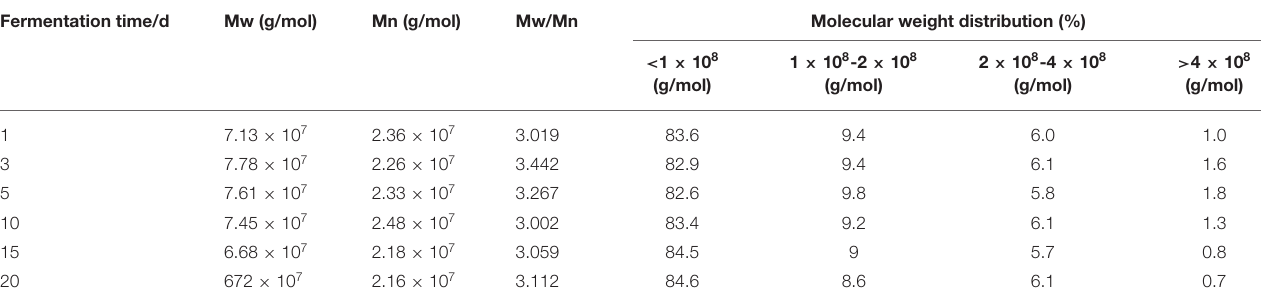
TABLE 5 | Effect of natural fermentation on the molecular weight of corn ballast starch. Fermentation time/d